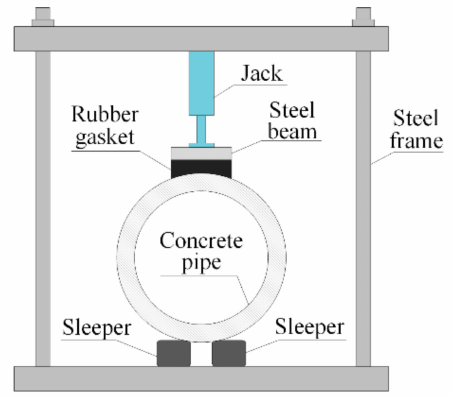
Figure 9. Loading